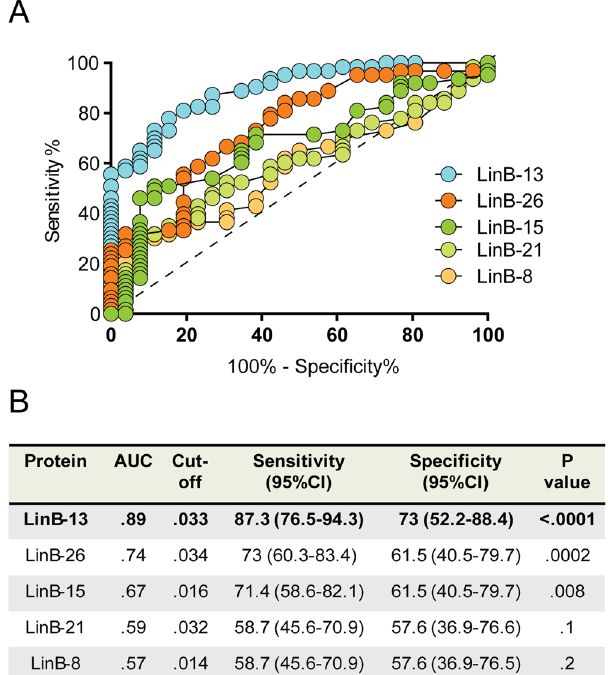
Figure 2. ROC antibody threshold level predicting ELISA positivity against Lu. intermedia SGS. ( A ) ROC curves were built using serology data from individuals seropositive (n = 63) or seronegative (n = 26) against Lu. intermedia salivary proteins. ( B ) Detailed information obtained from each ROC curve is shown: Area Under Curve (AUC), P values of the ROC curves, the cut-off values chosen, and sensitivity and specificity with the 95% confidence interval